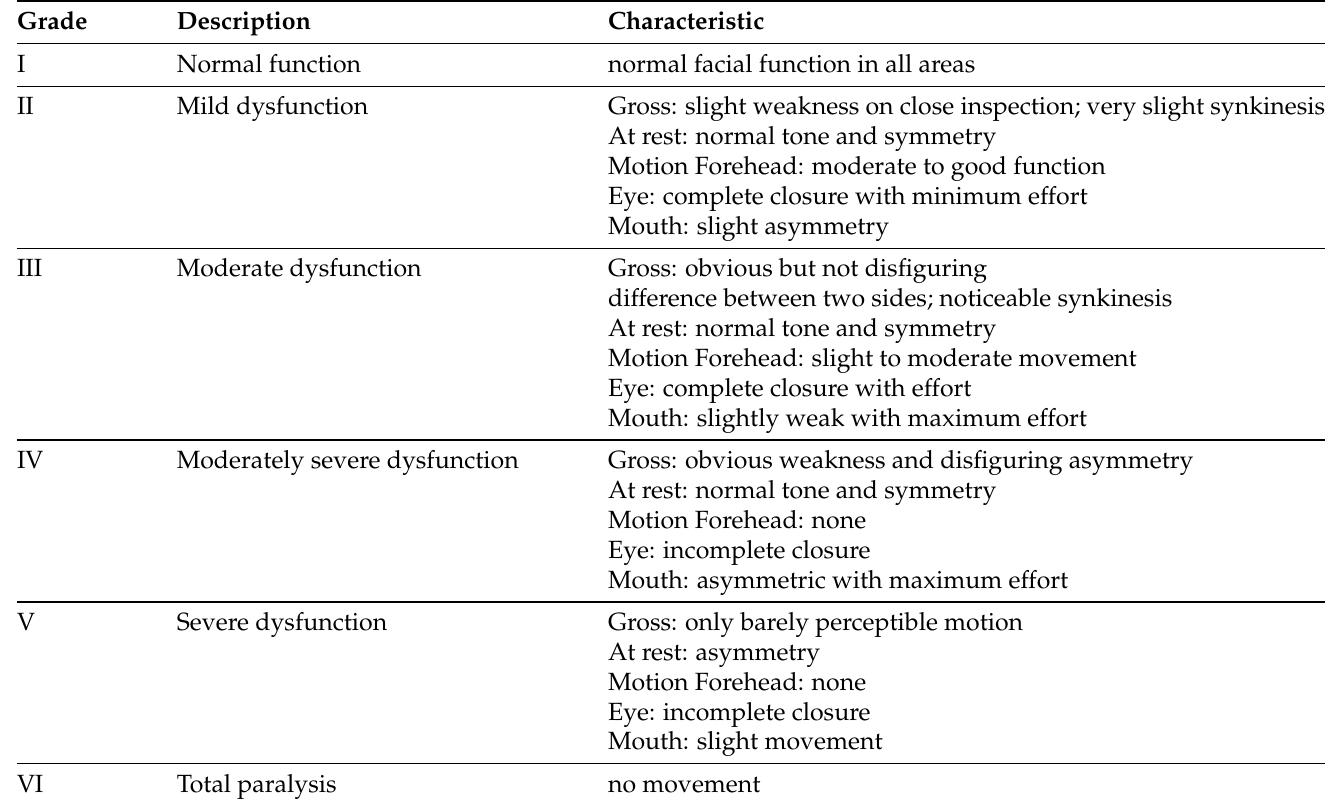
Table 1. House–Brackmann (HB) classification